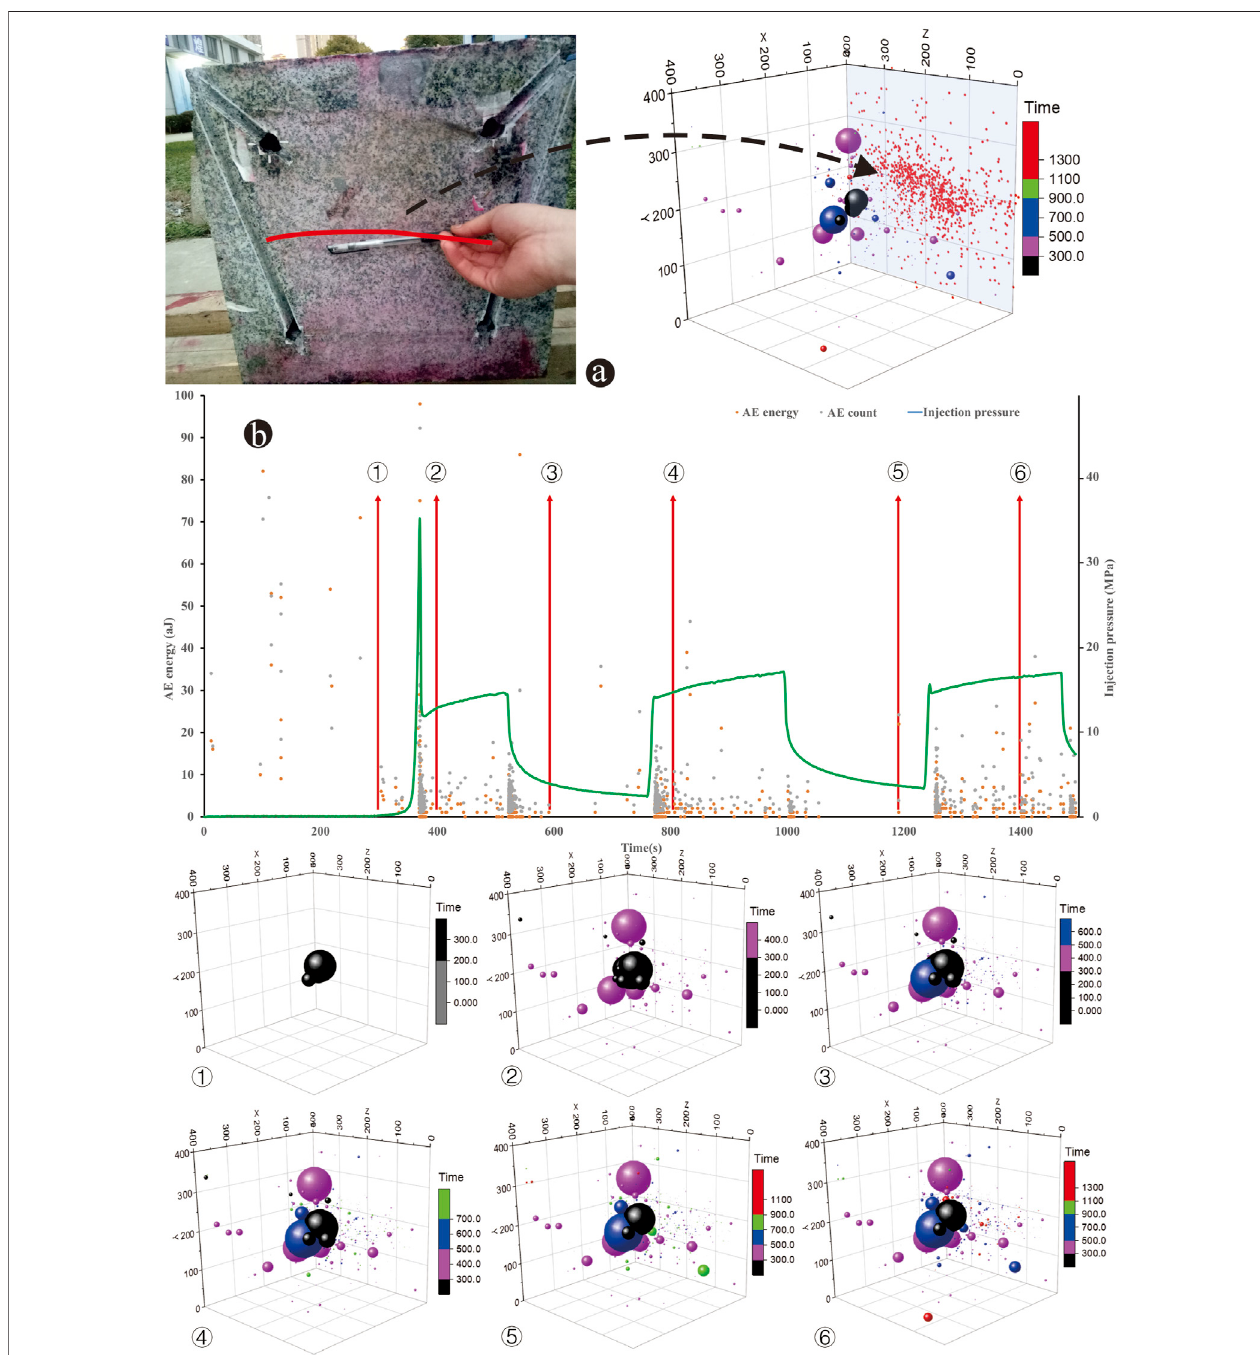
FIGURE 9 | AE spatial distribution characteristics of HDR400-4 (A) AE spatial distribution compared with the surface appearance of the sample; (B) AE spatial distribution of each pump periods. See Figure 7 for detailed fi gure description.